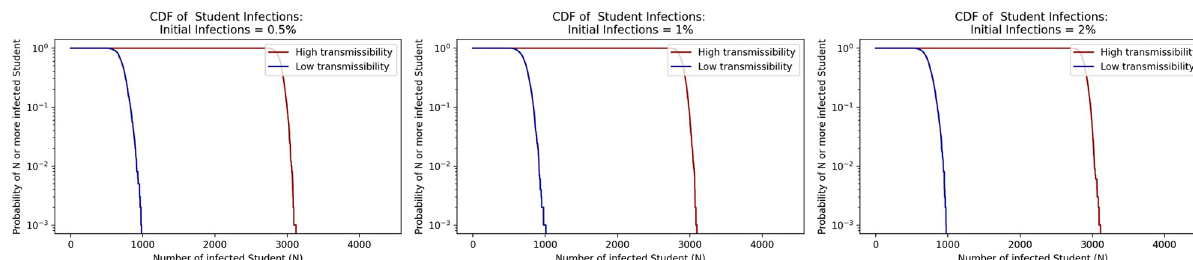
Fig 12. Sensitivity of model to initial infections rate parameter.